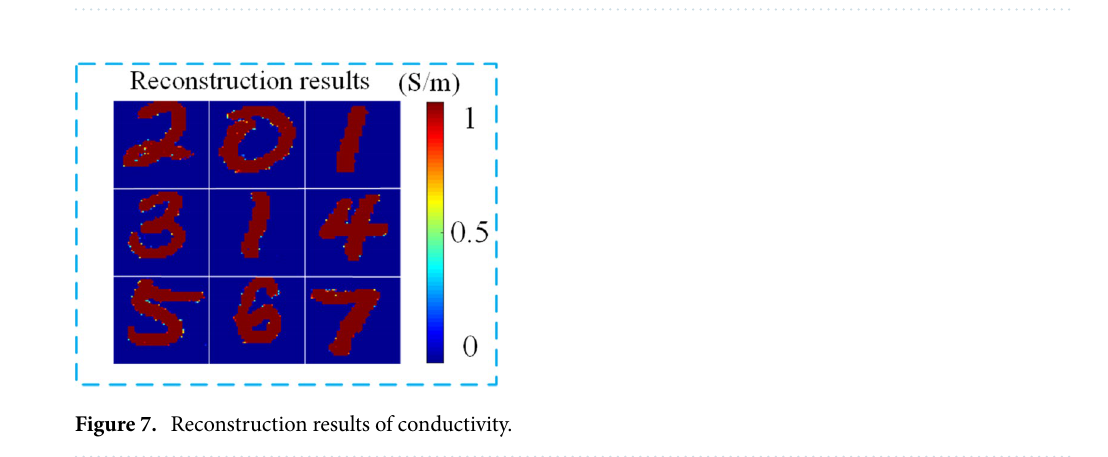
Figure 6. Calculation results of acoustic field: ( a ) direct reconstruction; ( b ) reconstruction after preprocessing.